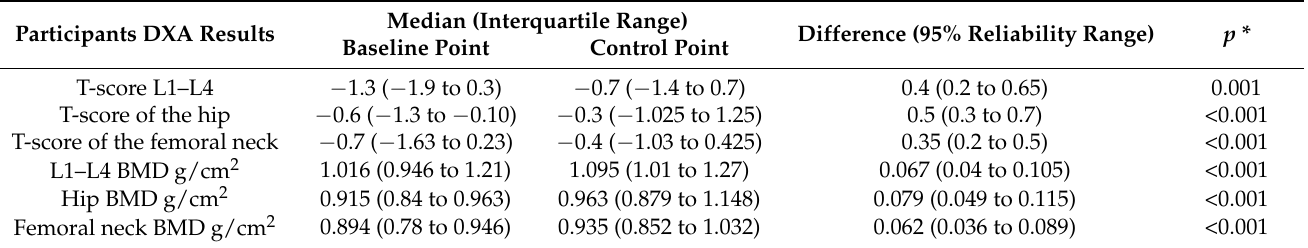
Table 4. Changes in DXA measurements of the lumbar spine, total hip, and femoral neck after one year of ATD treatment.